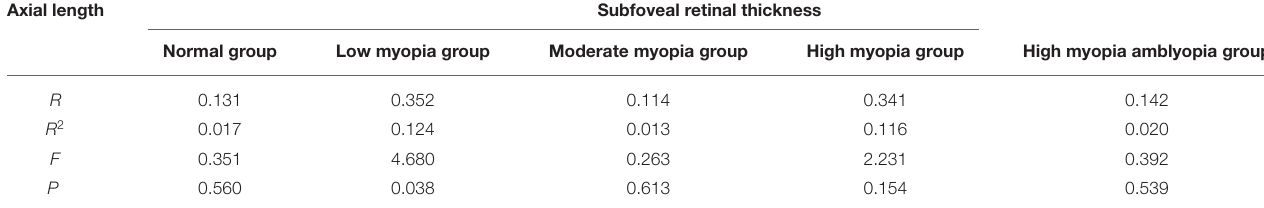
TABLE 7 | Correlation between subfovea retinal thickness and axial length in each group.